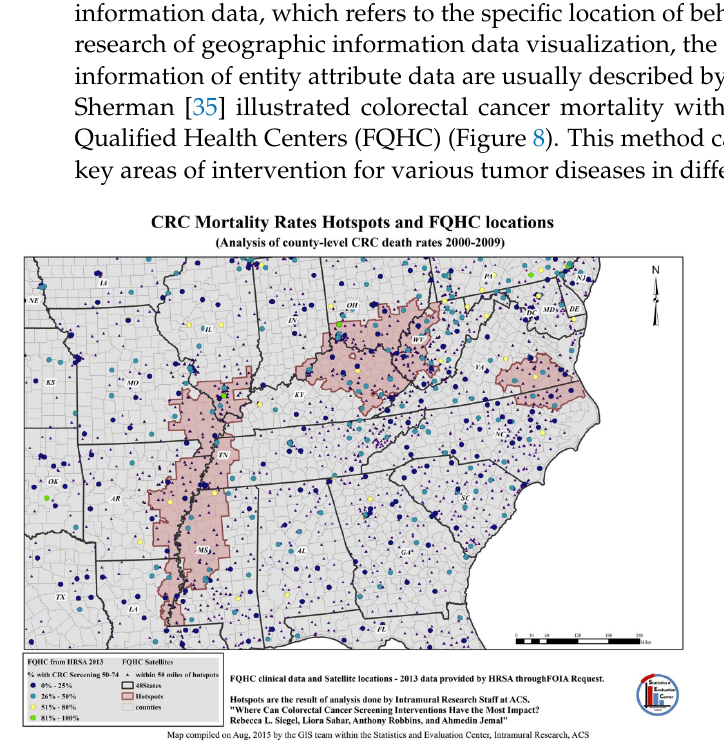
Figure 8. Point data visualization [35]. From blue to green, colorectal cancer mortality